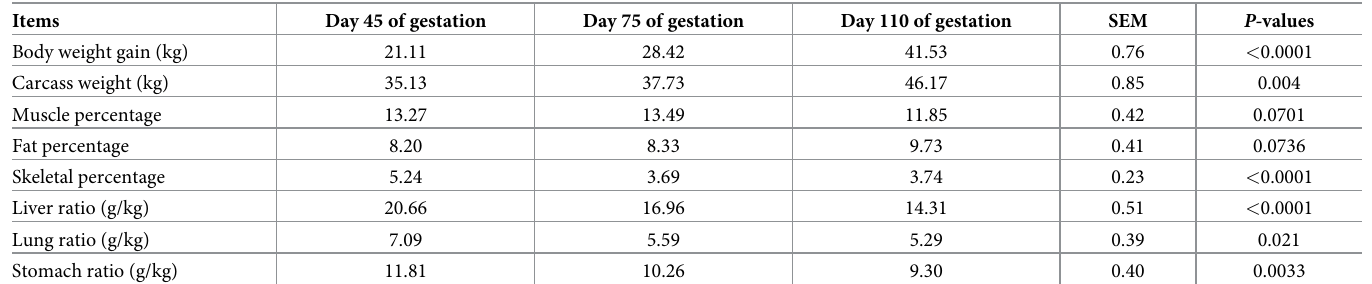
Table 3. The body composition and organ percentage of sows at different gestation period (n = 8).